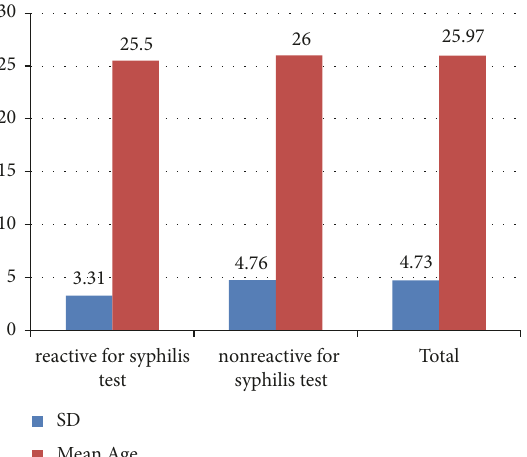
Figure 1: Age difference in pregnant mothers by their syphilis serostatus. Independent samples Student’s t -test: t (df = 208) = 3.245, p =